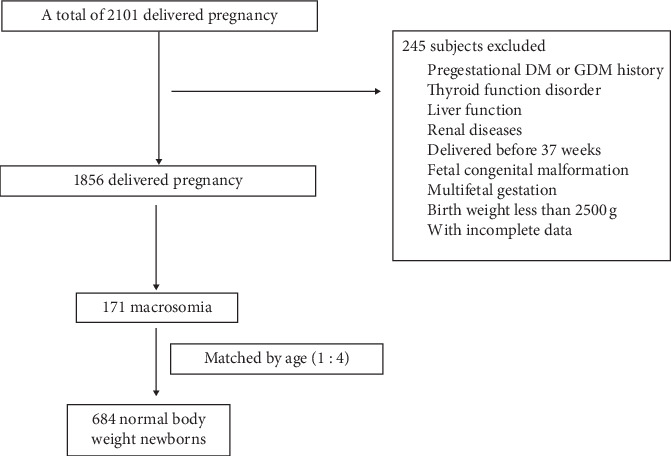
The flowchart of the analyzed population selection.